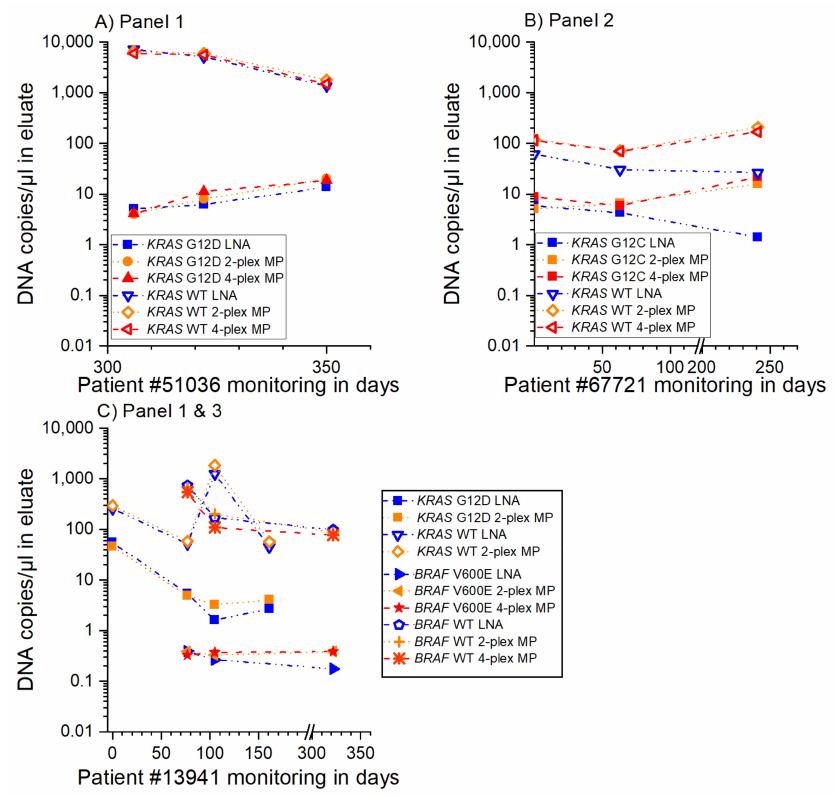
Figure 4. Therapy monitoring of patient samples for different sampling time points. The 2-plex and 4-plex MP ddPCR assay results coincided with the LNA reference assay results. ( A – C ) Therapy monitoring of three patients with three to five sampling time points and measurement of the three cancer-associated point mutations KRAS G12D, G12C, and BRAF